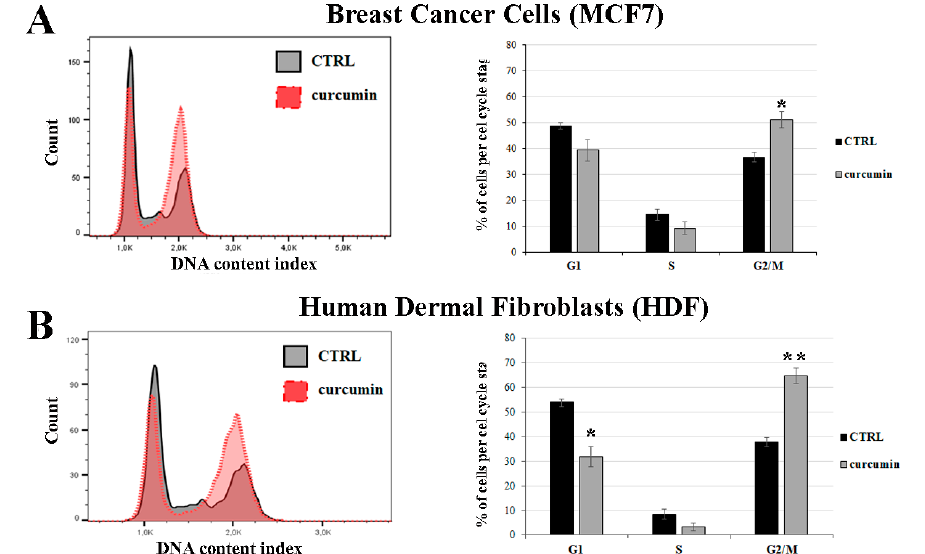
Figure 4. Effect of curcumin on cell cycle progression in MCF7 and HDF cells. ( A ) Breast cancer cells (MCF-7) and ( B ) human dermal fibroblasts (HDFs) treated with 10 µM of curcumin for 24 h and stained with propidium iodide (PI). DNA content was analyzed by flow cytometry. Results are represented as patterns of cells stained with propidium iodide (PI) before and after curcumin treatment (left). The percentage of cell population at different phases (G1, S, and G2/M) of the cell cycle is shown by histograms (right). The images are representative of three separate experiments. * p < 0.05 and ** p < 0.001 versus an untreated control.